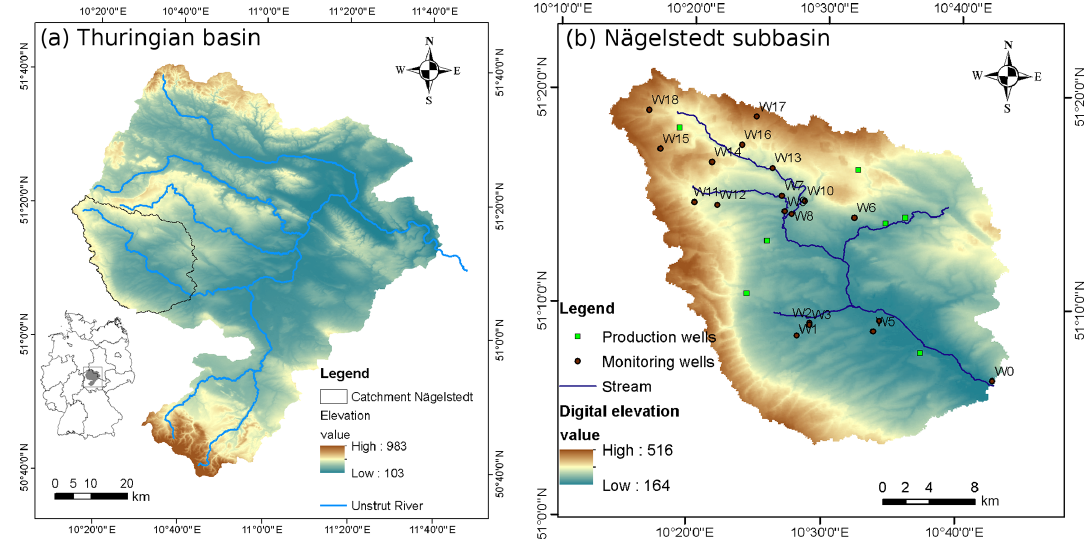
Figure 1. Study area and locations of pumping and monitoring wells within Nägelstedt subbasin. Panel (a) shows the relative position of Nägelstedt subbasin in Thuringian basin, and panel (b) shows the locations of pumping and monitoring wells in Nägelstedt